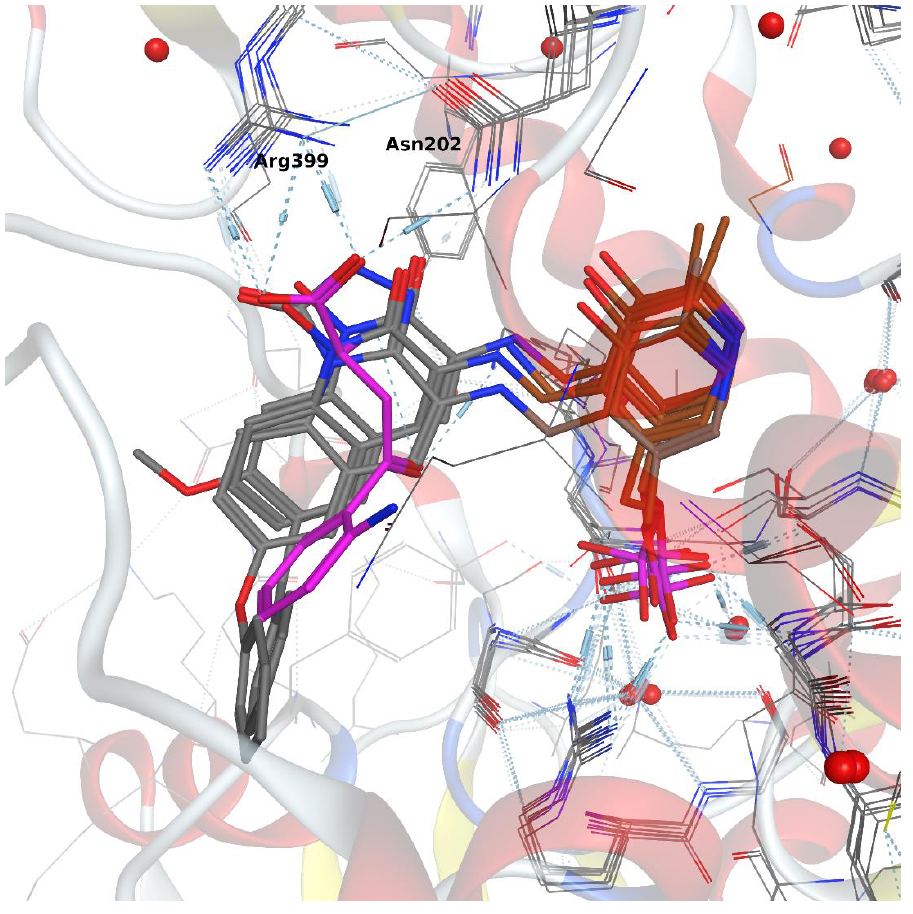
Figure 3. Overlay of inhibitors from pdb:4GDY, pdb:4UE8, pdb:4GE9, and pdb:2R2N inside of the KAT-II pocket. Kynurenine is shown in purple, and the PLP cofactor is shown in brown. Other inhibitors are shown in grey. Hydrogen bonding networks are shown as blue dotted lines.